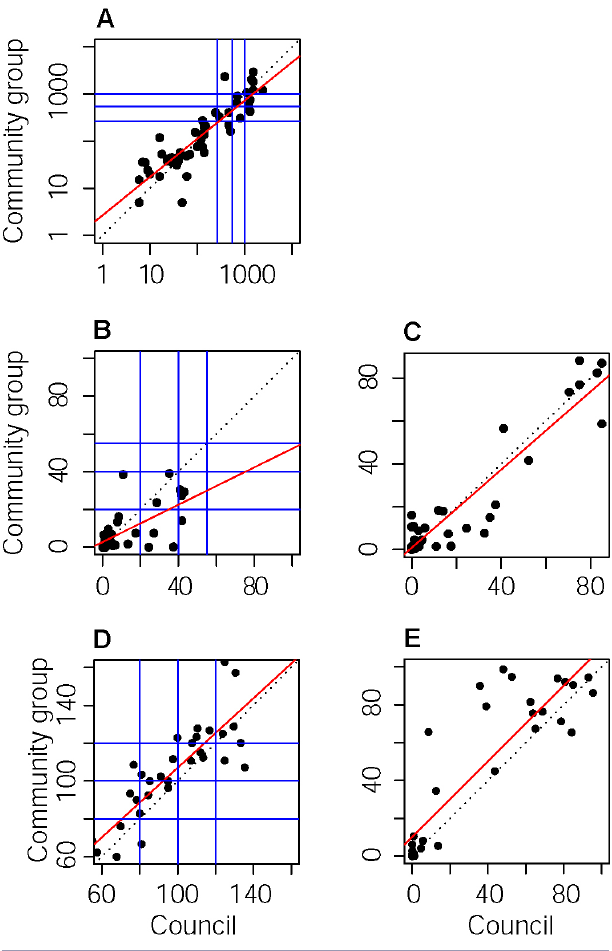
Fig. 2 . Relationships between community group and regional council (“council”) data for (A) E. coli (CFU/100 mL) on log scale, (B) Periphyton Weighted Composite Cover (%), (C) Periphyton cover (sum of mats, filaments, and sludge; %), (D) Community group Wai Care Macroinvertebrate Index (WMI) score vs. Council Macroinvertebrate Community Index (MCI) score, (E) %EPT (%). Dotted line indicates 1:1 relationship. Horizontal and vertical lines show condition bands according to New Zealand’s National Objectives Framework, or, for MCI, Stark and Maxted